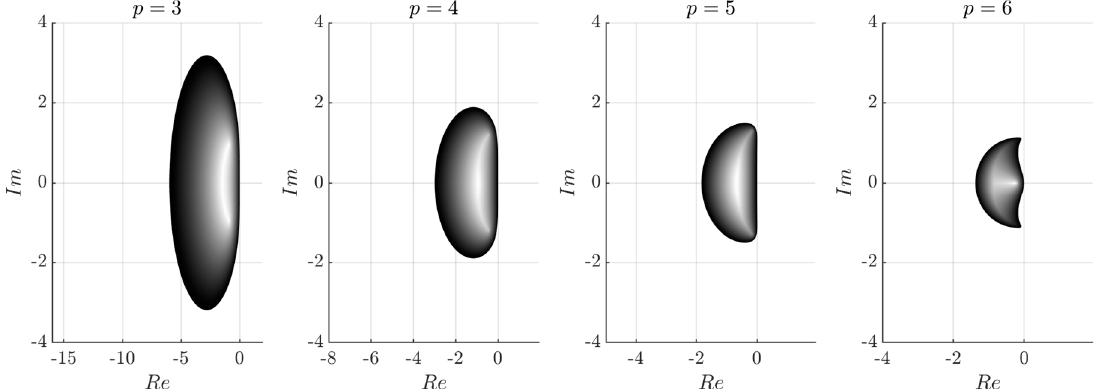
Fig. 13. Stability regions of Adams-Moulton methods of order p